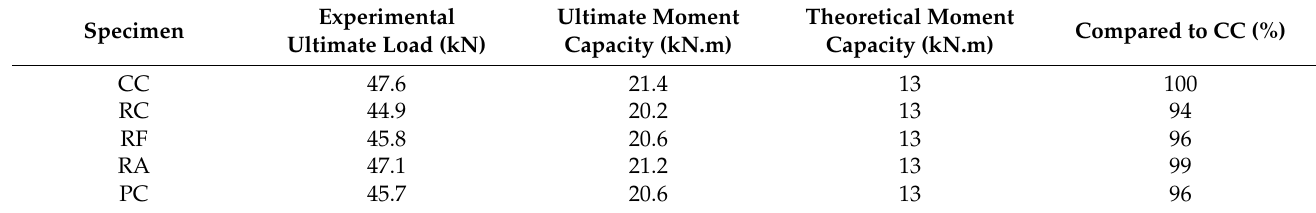
Table 6. Ultimate flexural capacity of the proposed